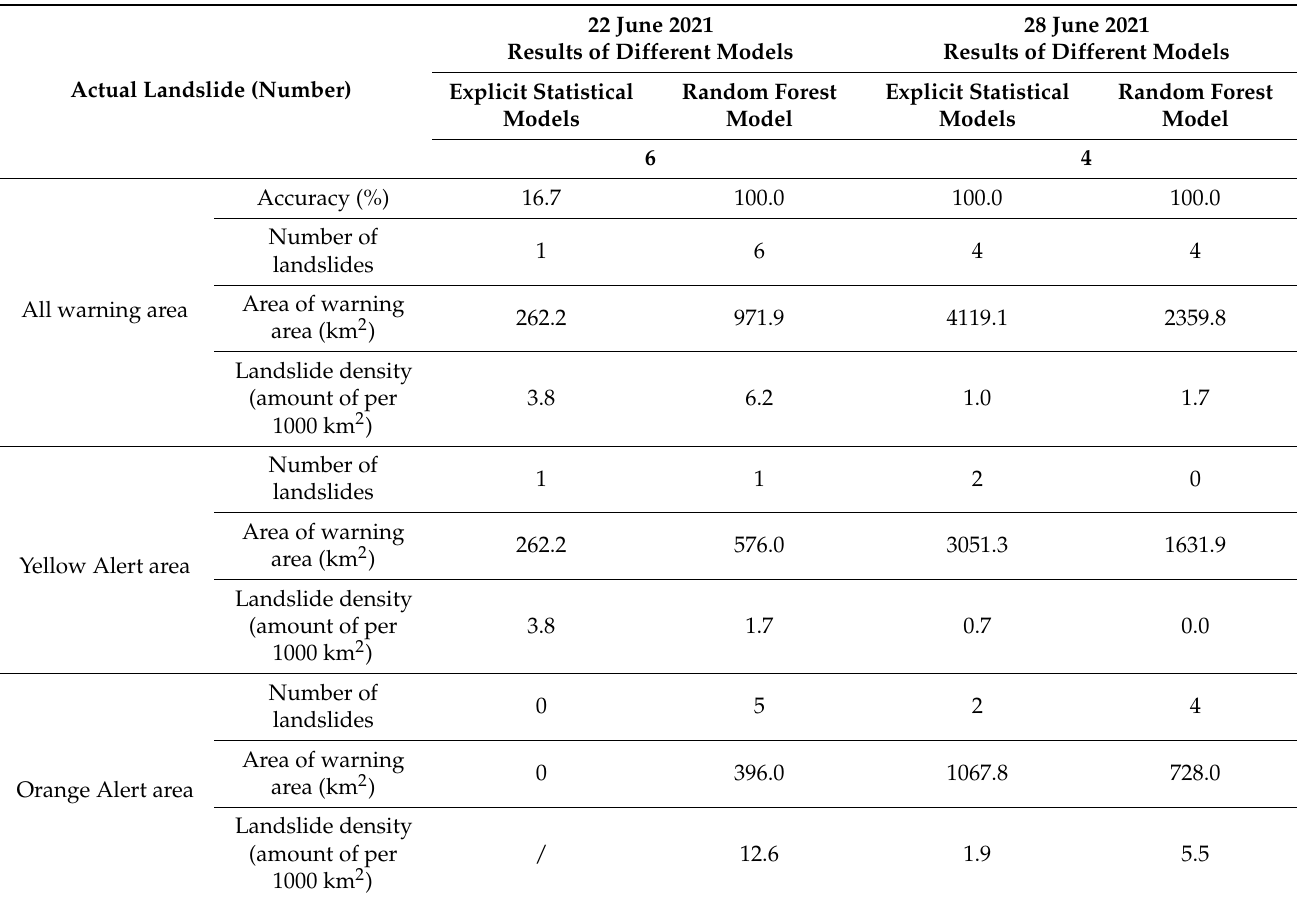
Table 6. Comparison between the Random Forest model and explicit statistical early-warning